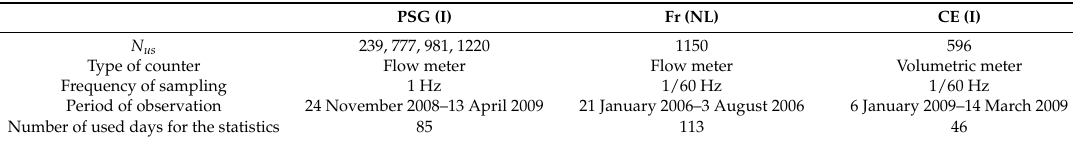
Table 1. Principal characteristics of the monitoring